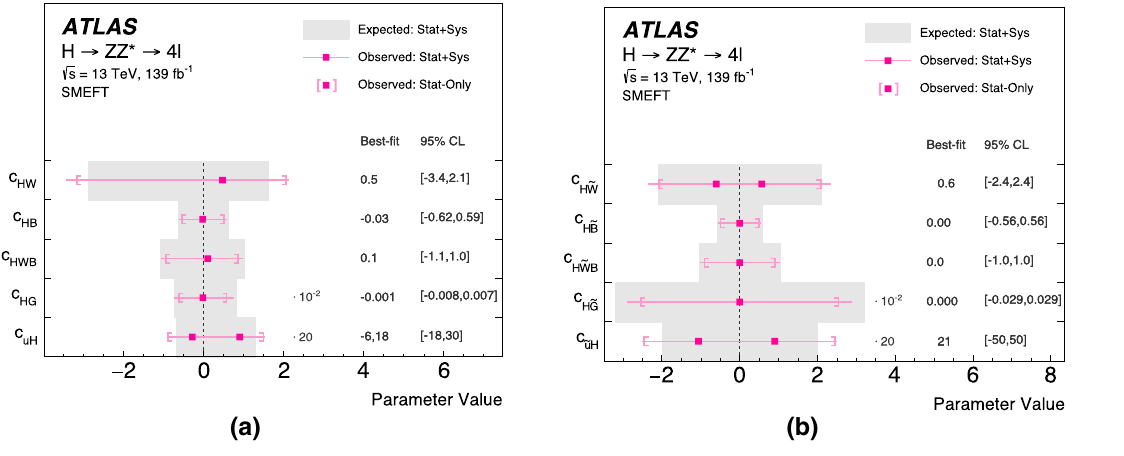
Fig. 16 The observed and expected values of SMEFT Wilson coef- coefficients are scaled by a factor of 100, and for for the c HG and c H ˜ G ficients from ( a ) CP-even and ( b ) CP-odd operators obtained for an the c uH and c ˜ uH coefficients by a factor of 0.05. The horizontal bands √ s = 13 TeV. Only one Wilson integrated luminosity of 139 fb − 1 at represent the expected measurement coefficient is fitted at a time while all others are set to zero. The values